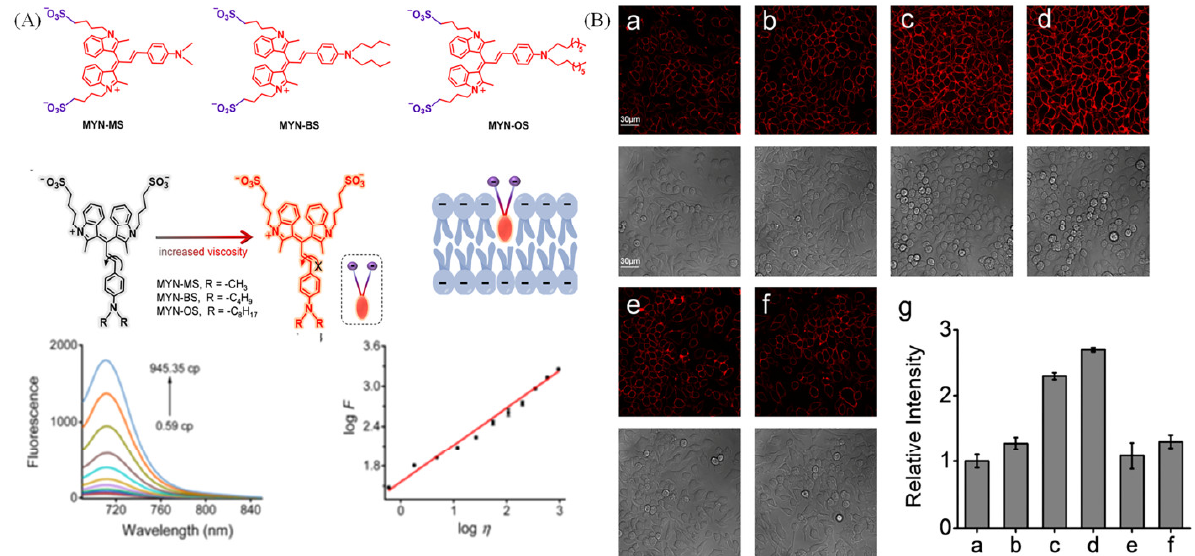
Figure 12. ( A ) Mechanisms of probes sensitive to plasma membrane viscosity and their fluorescence spectra in diverse viscous mixture. ( B ) Confocal images of macrophage-derived foam cells using various concentrations of ox-LDL (0 ( a ), 20 ( b ), 50 ( c ) or 100 ( d ) mg/mL), then stained with 10